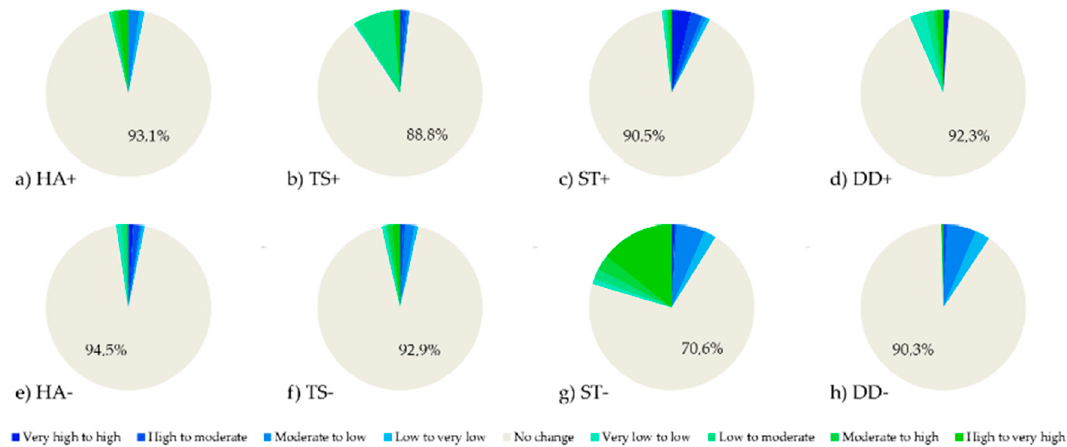
Figure 11. Classes switch for the sensitivity analysis on the criteria weight by the MIF method.